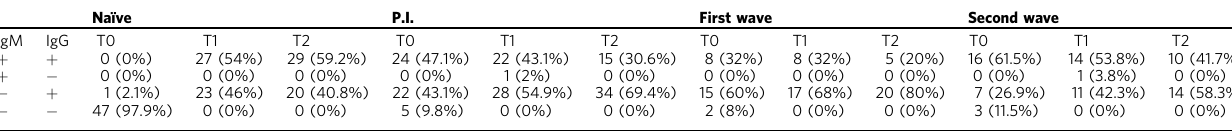
Table 3 Number and percent of IgM-S and IgG-S(RBD) positive subjects.